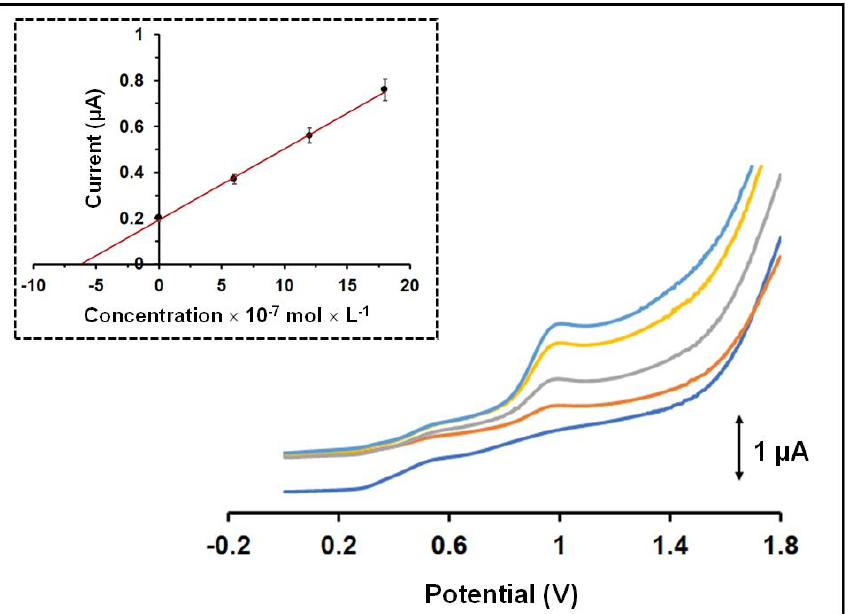
Figure 5. SW voltammograms for the determination of QF in urine sample using the 3D-printed sensor. Traces from below: unspiked urine sample, urine sample spiked with QF and 3 standard additions of 6 × 10 − 7 mol × L − 1 QF. The respective standard additions plot for QF is shown as inset. The points in the plot are the mean value ± sd ( n = 3). Applied potential: − 0.3 V; accumulation time: 120 s.